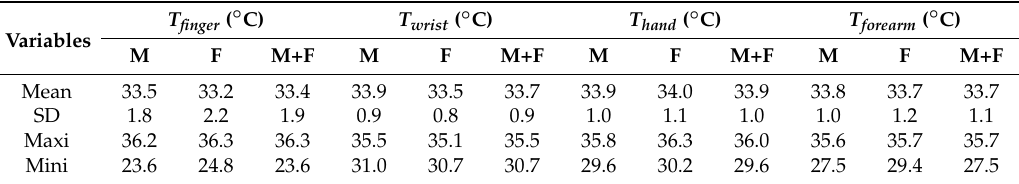
Table 4. Results of physiological